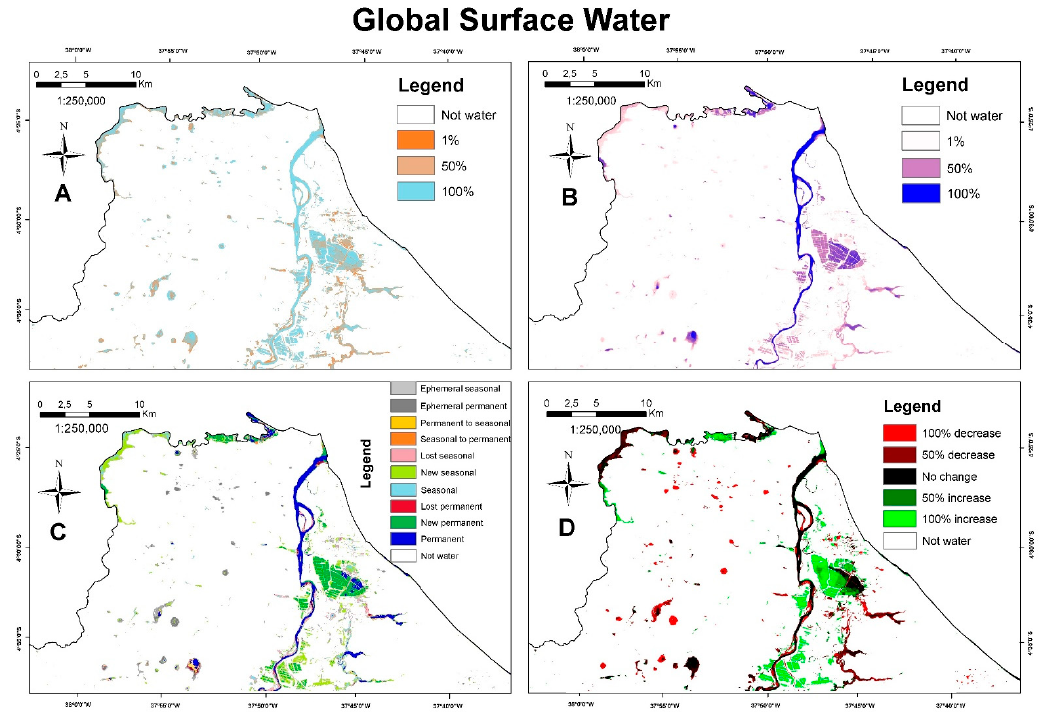
Figure 8. Surface water maps in the LJRSB coast showing water ( A ) recurrence, ( B ) occurrence, ( C ) transition, and ( D ) change intensity.